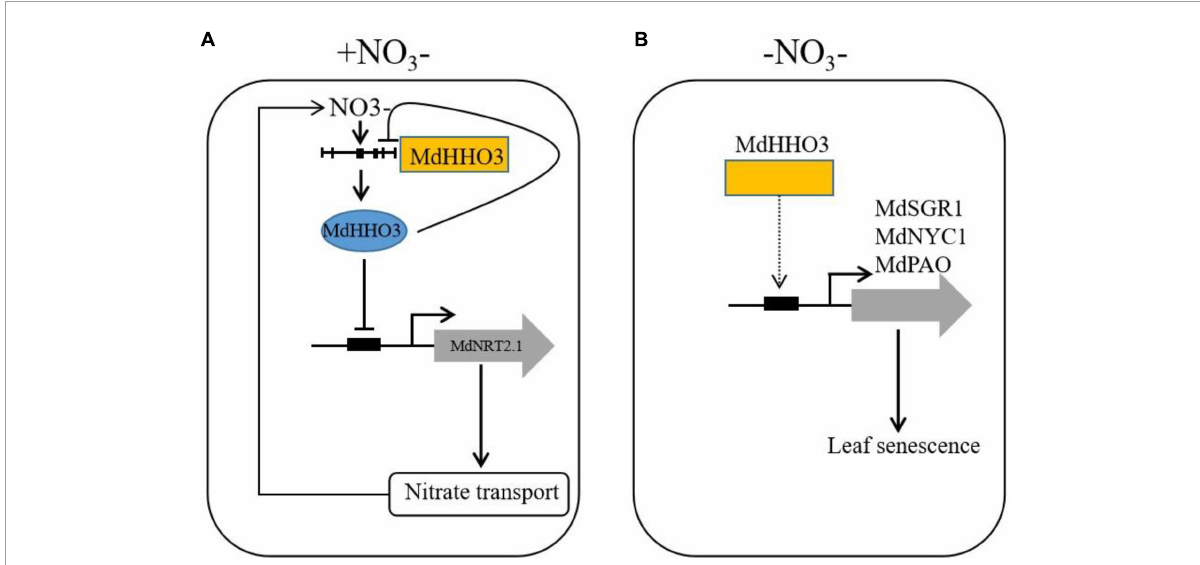
FIGURE9 Working model of the function of MdHHO3 in promoting leaf senescence in response to nitrate. (A) Transcriptional regulatory model of the modulation of nitrate uptake. Under the condition of nitrate supply, nitrate activates the MdHHO3 clade gene promoters and is then repressed by the expression of MdHHO3 . MdHHO3 binds to the MdNRT2.1 promoter and inhibits its expression. (B) Model of MdHHO3 regulating leaf senescence. In the absence of nitrate, MdHHO3 regulates the expression of the senescence-related genes and thus promotes leaf